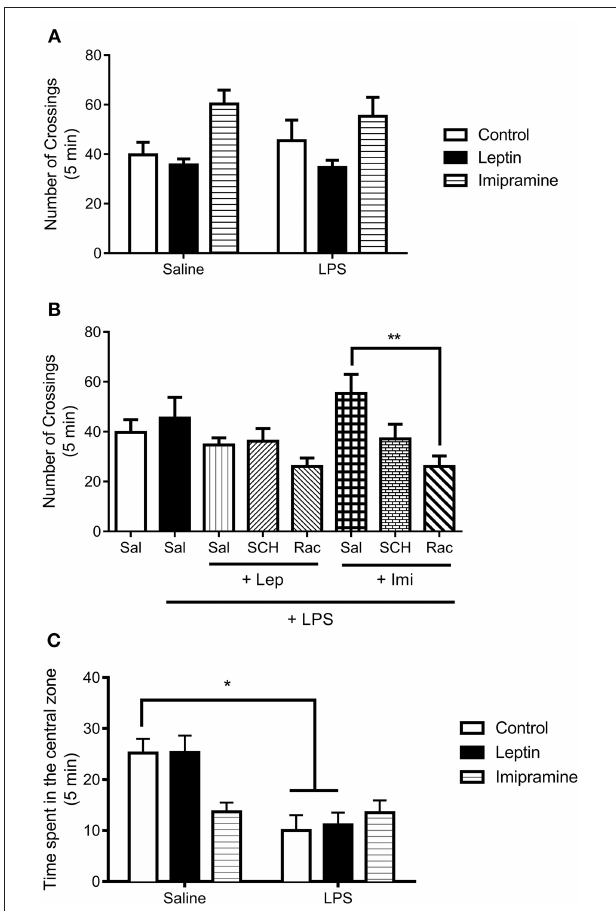
FIGURE 3 | Number of crossings in the open field test of animals submitted to protocol 1 (A) and protocol 2 (B) . Time spent in the center of the open field (C) . Bars represent mean ± standard error of the mean (S.E.M.) of 6–10 animals/group. The results in part A and C were analyzed by two-way ANOVA, while in part B by one-way ANOVA, in both cases with Tukey’s as post-hoc test. * P < 0.05 , ** P < 0.01 as indicated by the connectors. Sal, saline; SCH,